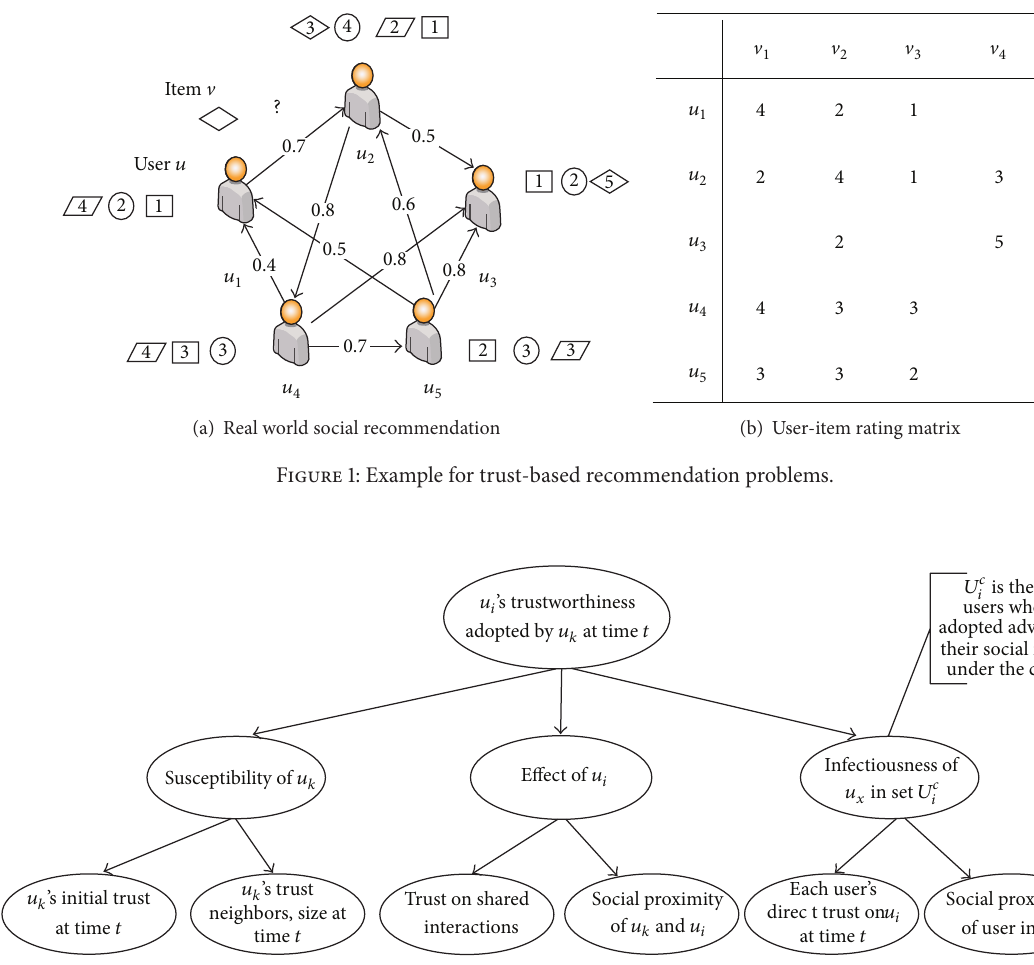
Figure 2: Trust Diffusion